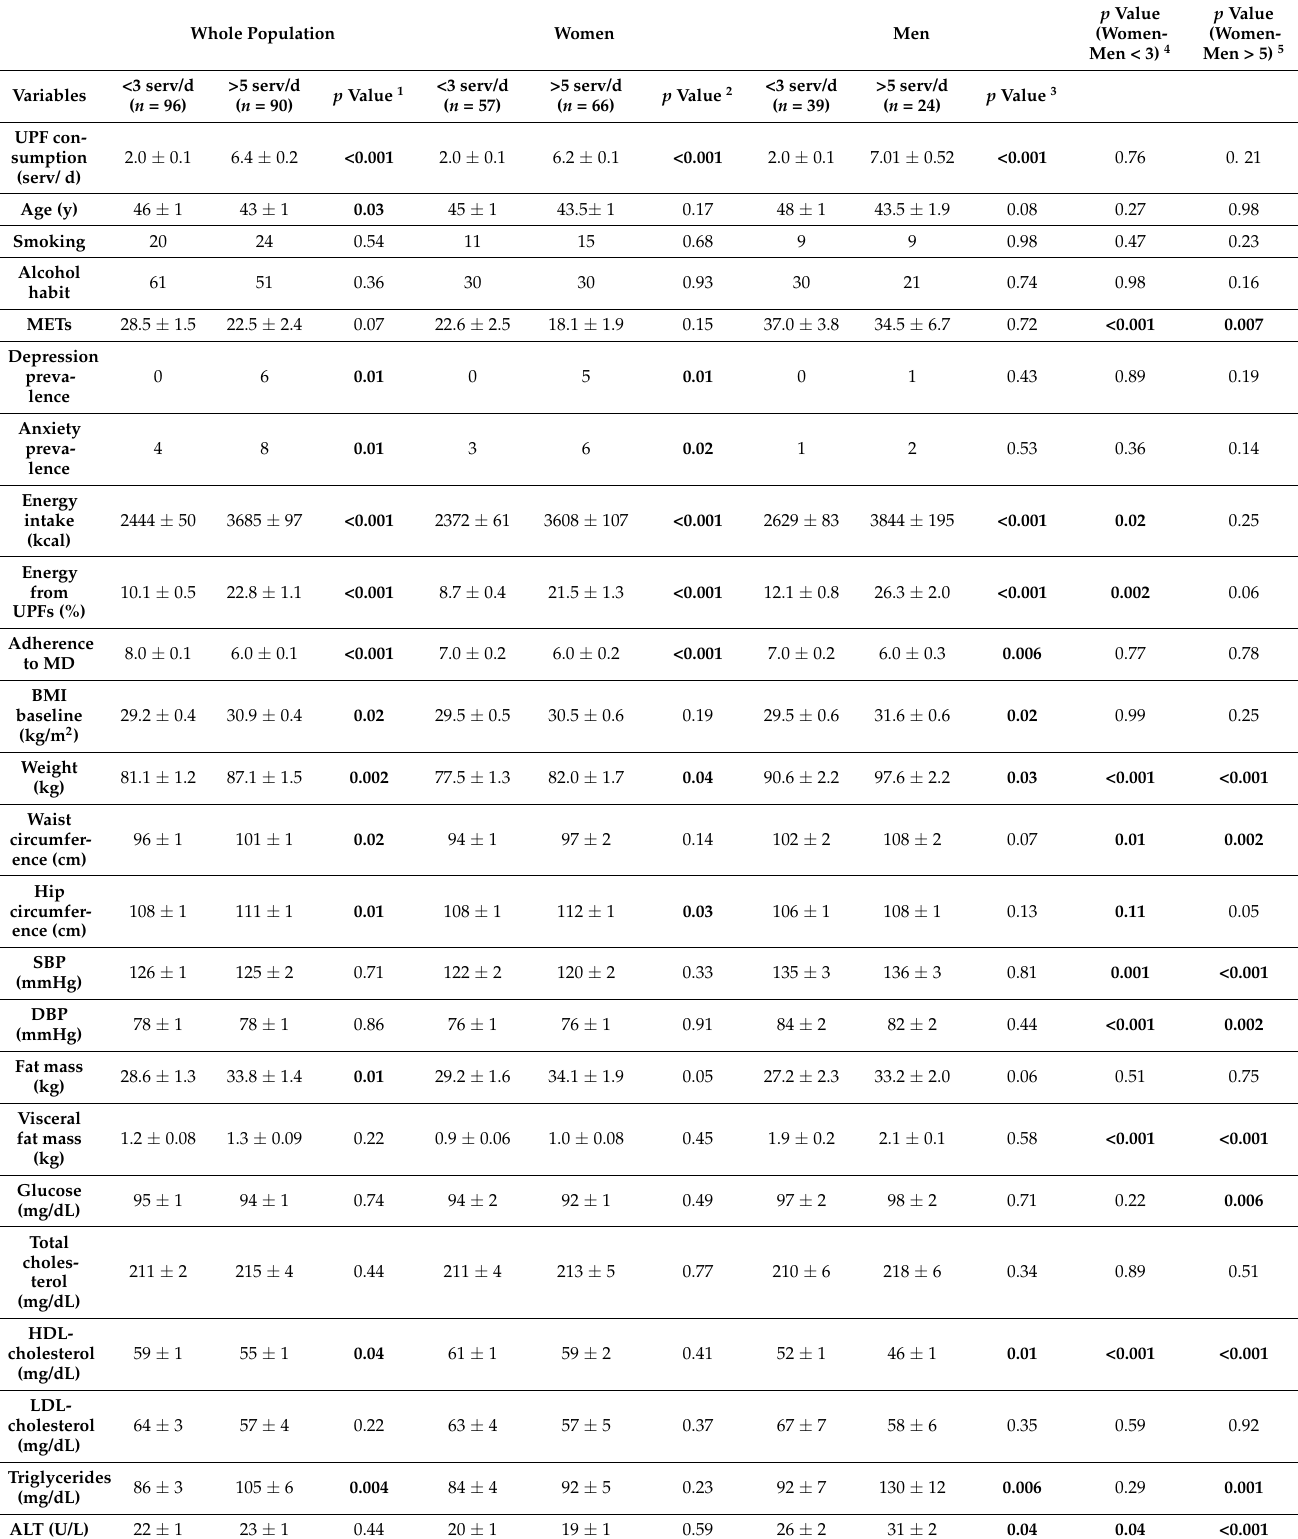
Table 1. Characteristics of the participants according to UPFs consumption categorized according to <3 servings per day and >5 servings per